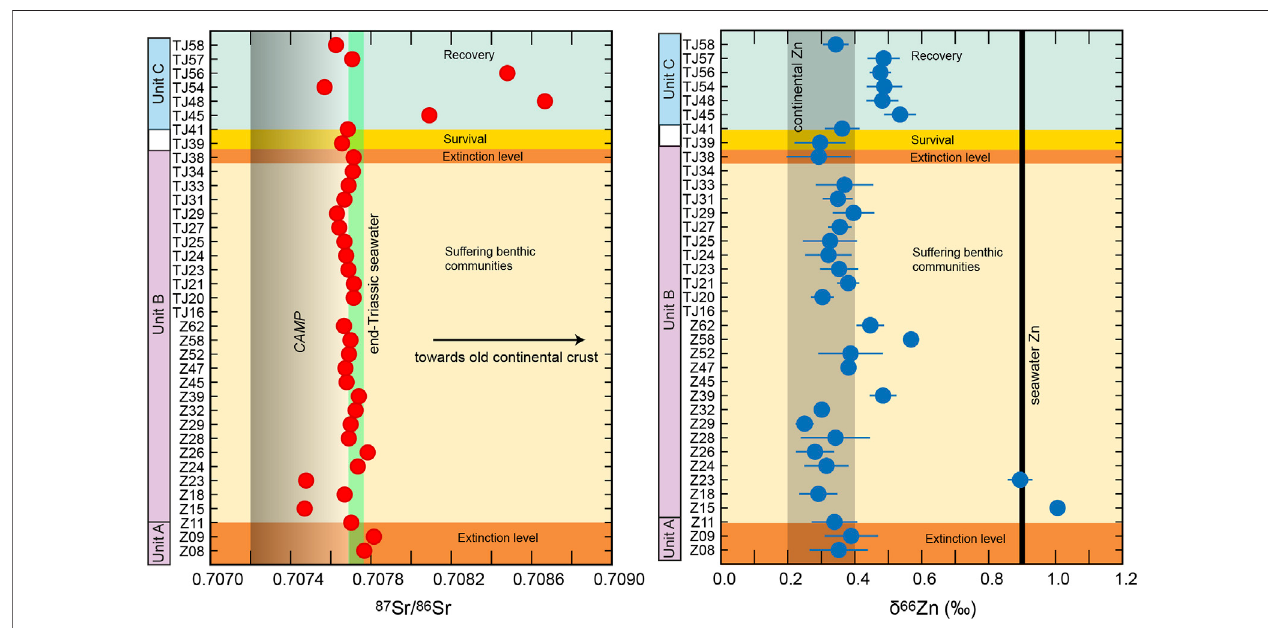
FIGURE 4 | 87 Sr/ 86 Sr values and δ 66 Zn values of the Mt Sparagio section correlated to the three Units and to the extinction events (not in scale).